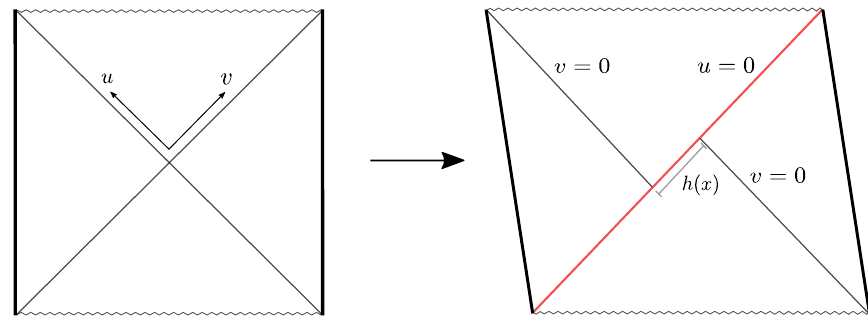
Figure 2 . An illustration of the shockwave spacetime. By sending in a localized energy packet from the left boundary around a scrambling time in the past, the backreaction is described by a localized shockwave on the horizon at u = 0 with profile h ( x )